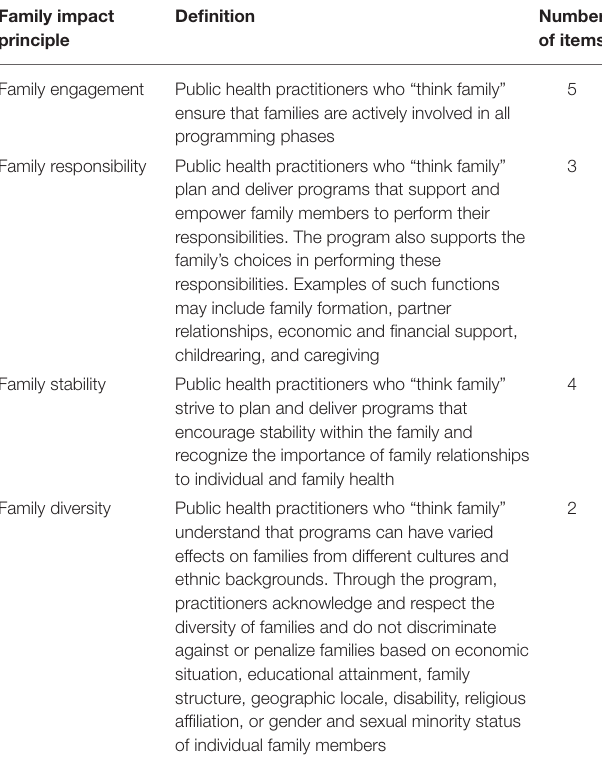
TABLE 1 | Description of public health family impact principles and